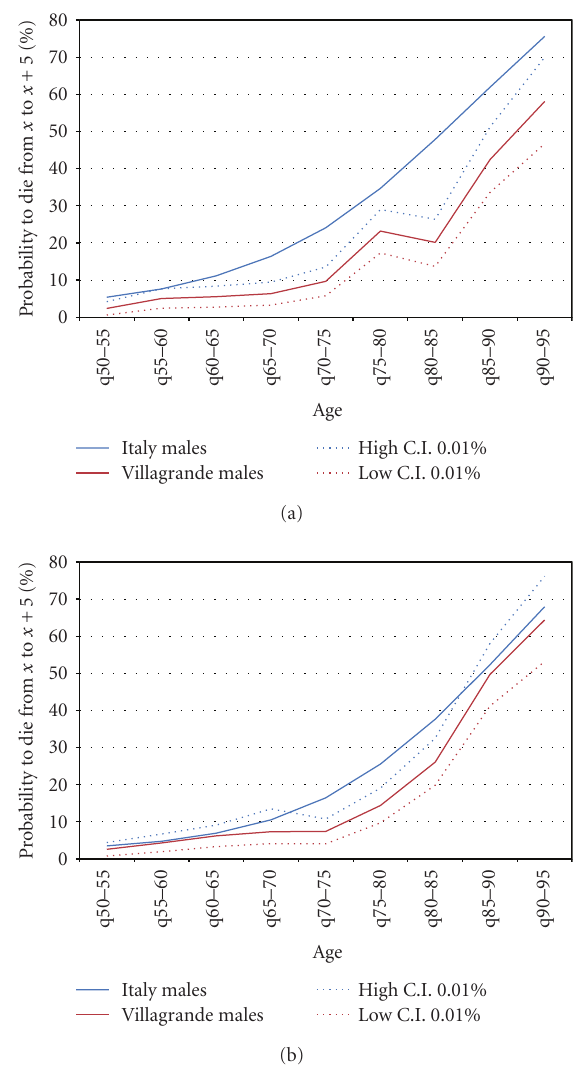
Figure 3: (a) Compared five years’ probability of dying for males in Villagrande with strictly comparable data extracted from the HMD for the whole Italy (birth cohorts from 1876 till 1912 included). (b) Compared five years’ probability of dying for females in Villagrande with strictly comparable data extracted from the HMD for the whole Italy (birth cohorts from 1876 till 1912